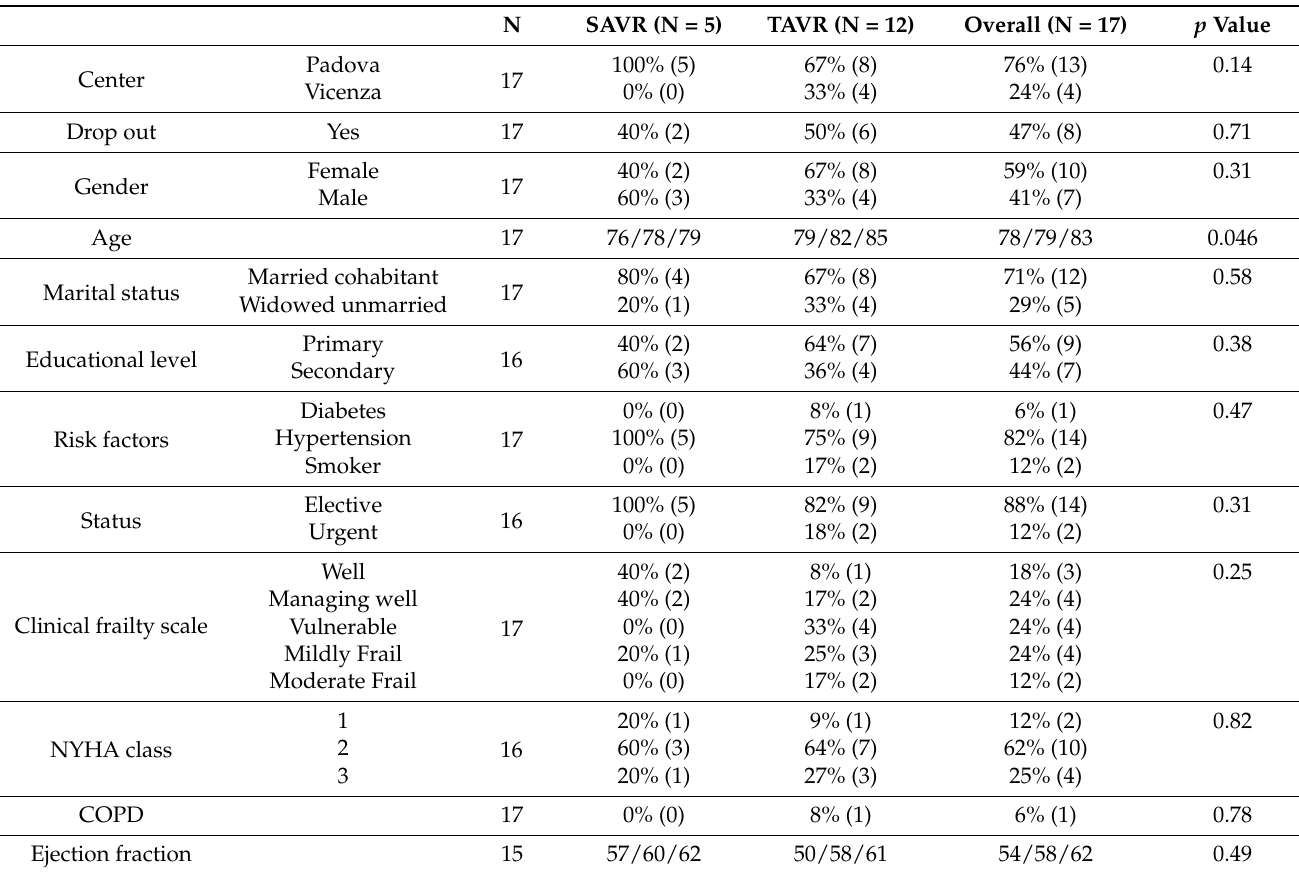
Table 1. Baseline characteristics of the sample according to the type of intervention, surgical aortic valve replacement (SAVR) or transcatheter aortic valve replacement